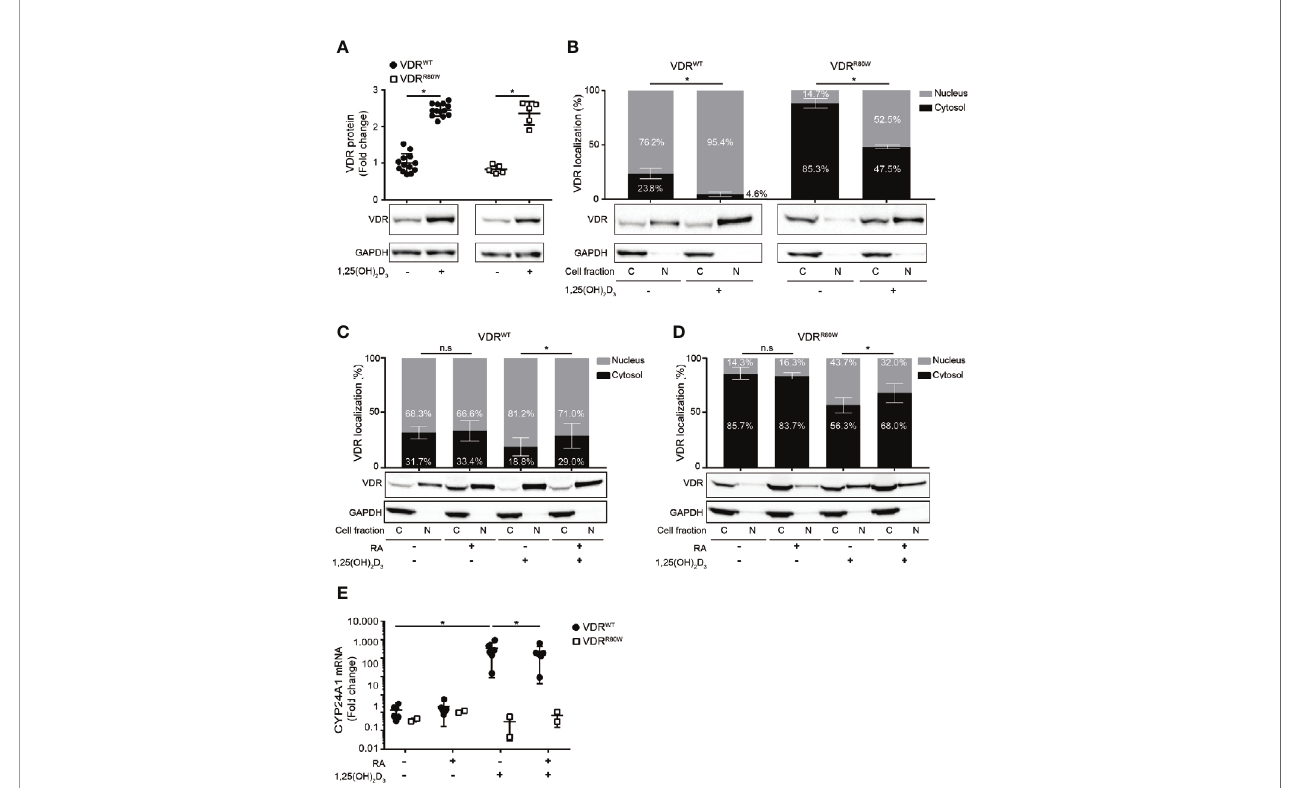
FIGURE 3 | The R80W mutation does not affect binding to 1,25(OH) 2 D 3 and RXR but signi fi cantly affects the subcellular localization of VDR R80W (A) Relative VDR protein expression as determined by the density of the VDR bands from Western blotting analysis of VDR WT and VDR R80W CD4 + T cells activated in the absence (-) or presence (+) of 1,25(OH) 2 D 3 (10 nM). The upper panel gives the density of VDR WT (black circles) and VDR R80W (white squares) normalized to the average density of the VDR WT bands from control cells activated in the absence of 1,25(OH) 2 D 3 . The lower panel shows one representative Western blotting analysis out of fi ve independent experiments of VDR and GAPDH (loading control) from control and patient cells. Mean ± SD (VDR WT n = 13; VDR R80W n = 1 repeated 5 times; *p < 0.05). (B – D) Subcellular localization of VDR WT and VDR R80W in CD4 + T cells activated in (B) the absence (-) or presence (+) of 1,25(OH) 2 D 3 (10 nM) and in (C, D) the absence (-) or presence (+) of RA (1 µM) and 1,25(OH) 2 D 3 (10 nM). The upper panels show the fraction of VDR located to the nucleus and the cytosol in grey and black columns, respectively, as determined by the density of the VDR bands from the Western blots. The lower panels show one representative Western blotting analysis of VDR and GAPDH (loading control) from the cytosolic (C) and nuclear (N) fraction of CD4 + T cells activated in the absence (-) or presence (+) of 1,25 (OH) 2 D 3 and RA as indicated. (B) Mean ± SD (VDR WT n = 14; VDR R80W n = 1 repeated 5 times; *p < 0.05). (C, D) Mean ± SD (VDR WT n = 8; VDR R80W n = 1 repeated 3 times; *p < 0.05). (E) Relative mRNA expression of CYP24A1 in VDR WT (black circles) and VDR R80W (white squares) CD4 + T cells activated in the absence (-) or presence (+) of RA (1 µM) and 1,25(OH) 2 D 3 (10 nM). The expression levels are given as fold change normalized to the average expression level of CYP24A1 in control cells activated in the absence of RA and 1,25(OH) 2 D 3 . Mean ± SD (VDR WT n = 6; VDR R80W n = 1 repeated twice; *p <